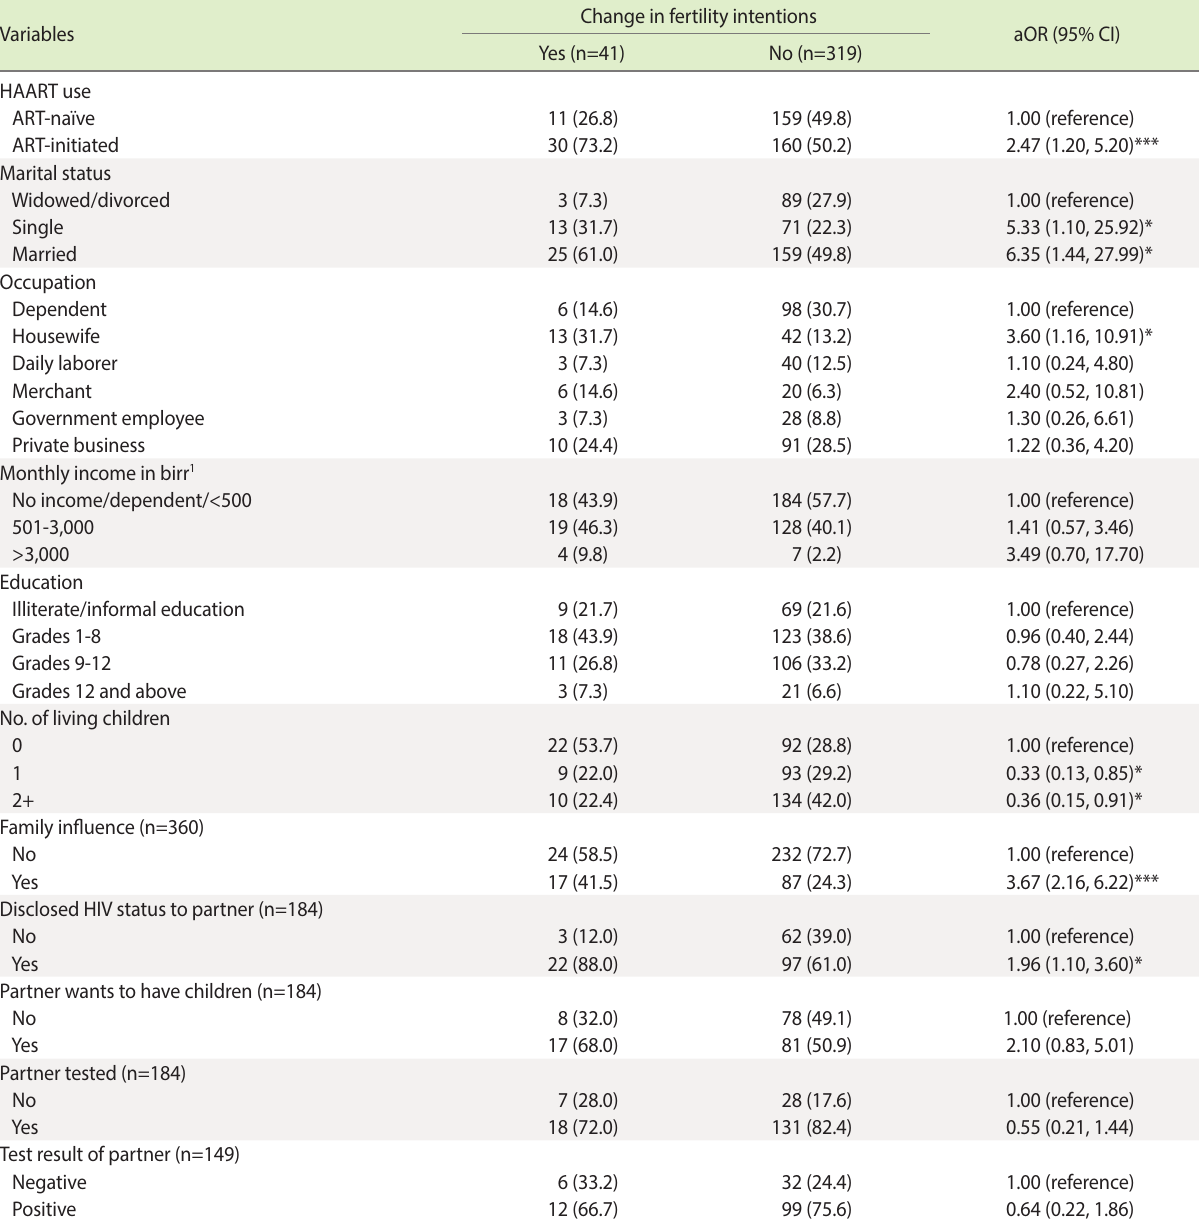
Table 3. Adjusted logistic regression analysis of changes in fertility intentions among HIV-positive women at the 12-month follow-up visit, Addis Ababa,